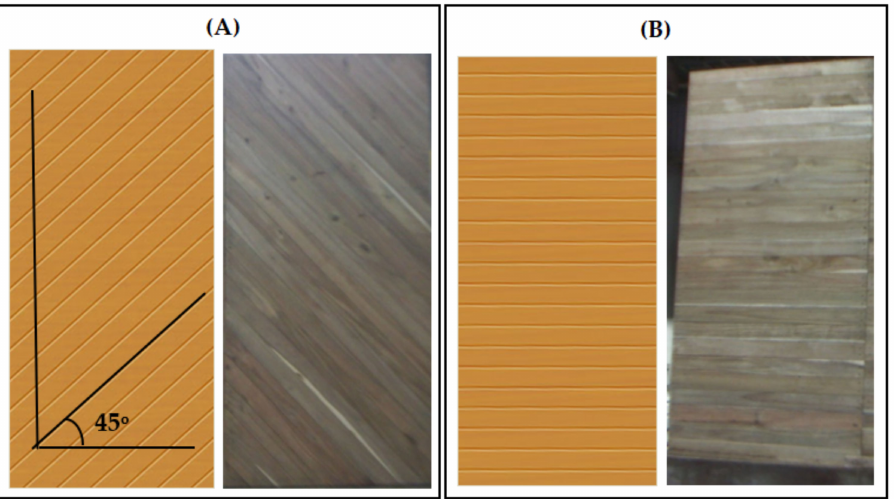
Figure 3. Schematic of wall specimens CLT-mangium used as shear wall frames. ( A ) 45 ◦ diagonal sheathing wall test specimens; ( B ) Straight sheathing wall test specimens.